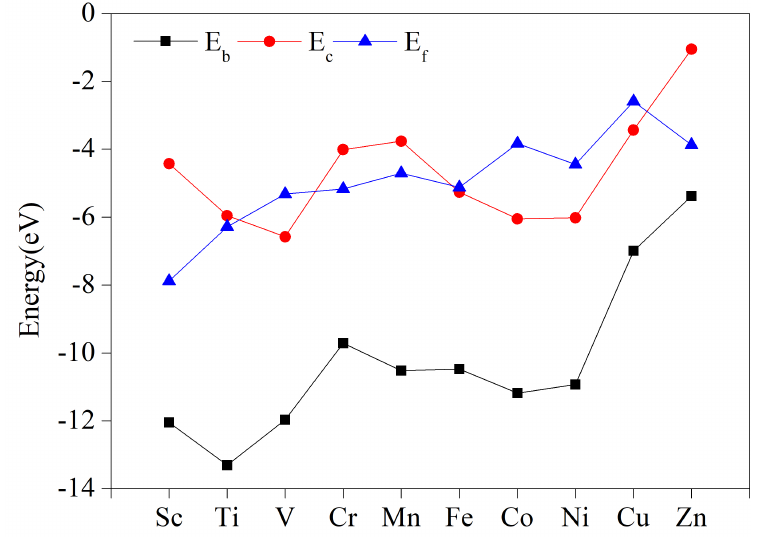
Figure 2. Stability of different TM-HAB monolayers structurally. TM is the transition metal atom, E c is the cohesive energy of the TM bulk, E b is the binding energy between TM and HAB in TM-HAB, and E f is the formation energy of